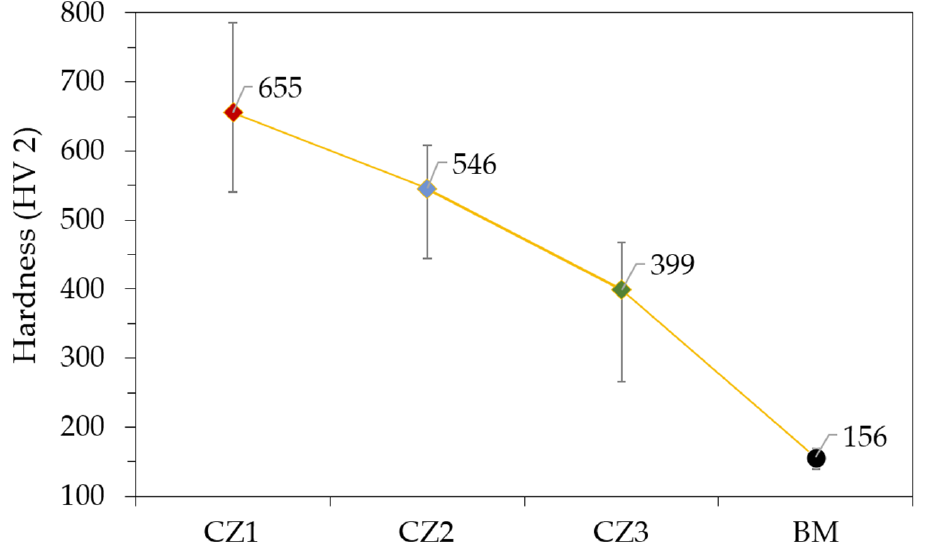
Figure 6. Vickers hardness variation from the CZ1 zone to the base metal (BM). Table 1. Hardness of the precipitated carbides in the composite